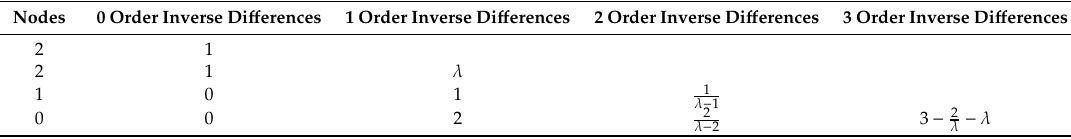
Table 5. Table of inverse di ff erences with a